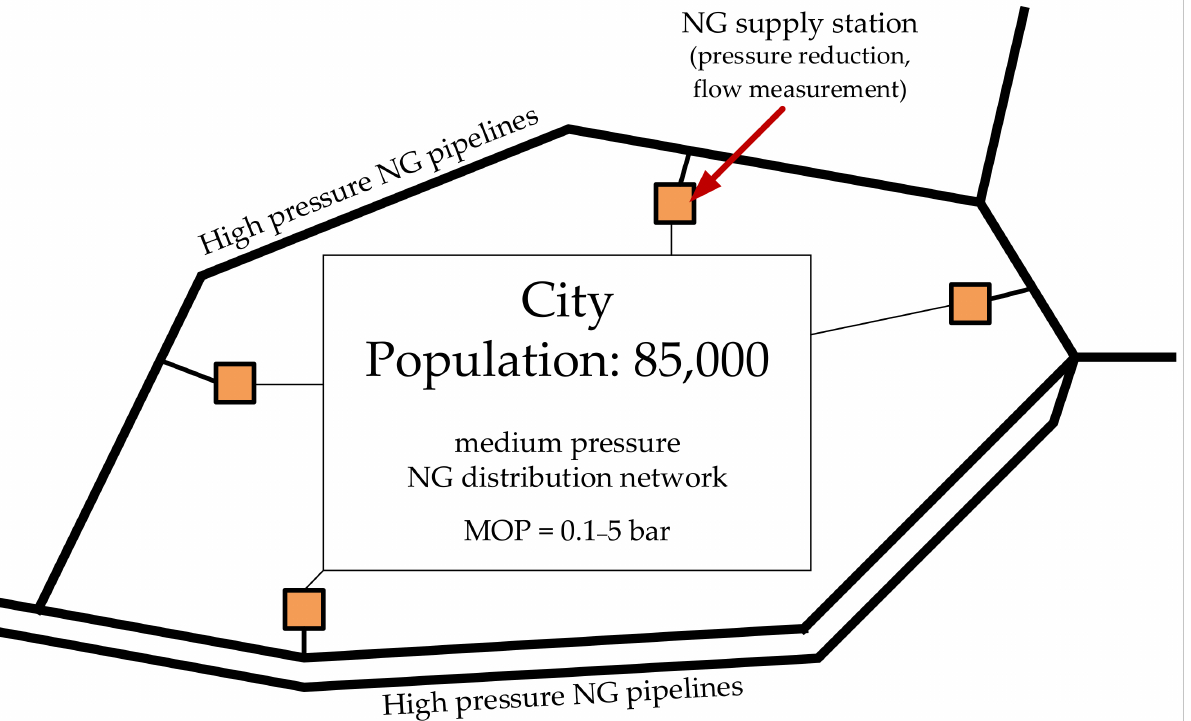
Figure 2. The schematic map of analyzed